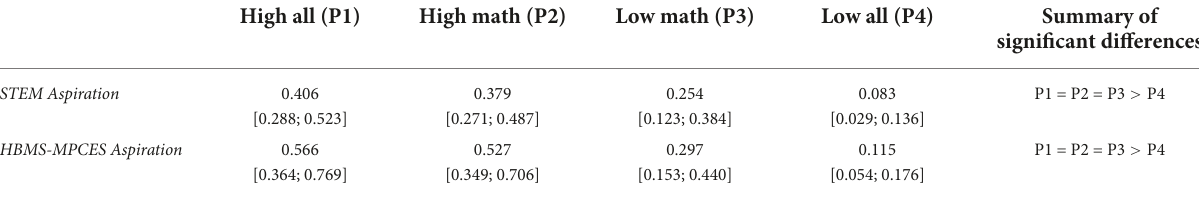
TABLE 3 Science, technology, engineering and math (STEM) aspiration difference in each